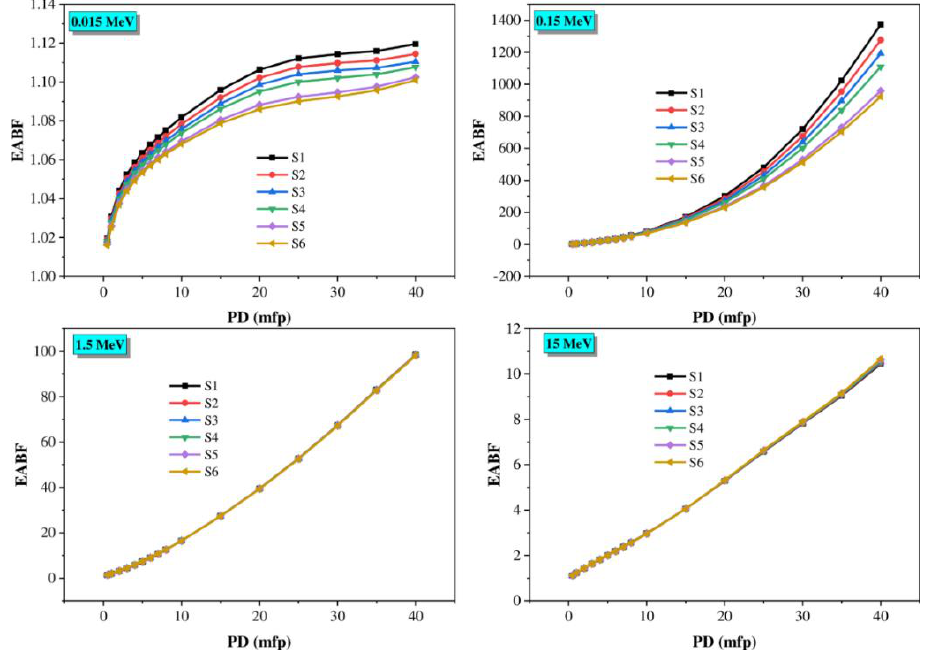
Figure 15. EABF changes against the penetration depth of the glasses at various gamma photon energies (0.015, 0.15, 1.5, and 15 MeV).